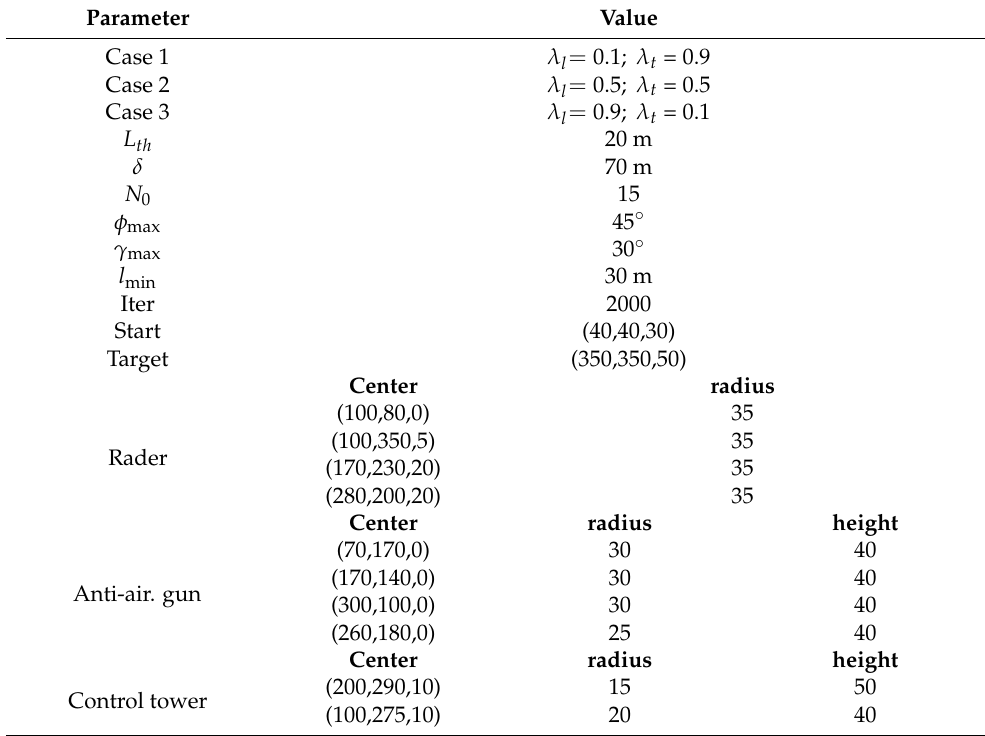
Table 1. Parameter values.